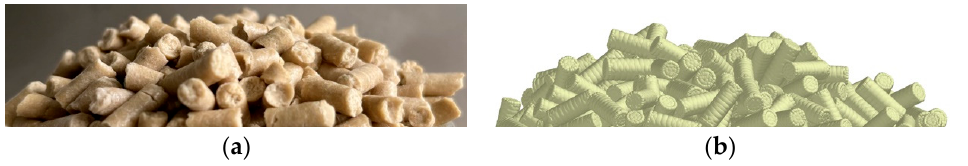
Figure 8. Comparison of actual test and simulation test. ( a ) Actual test. ( b ) Simulation test.